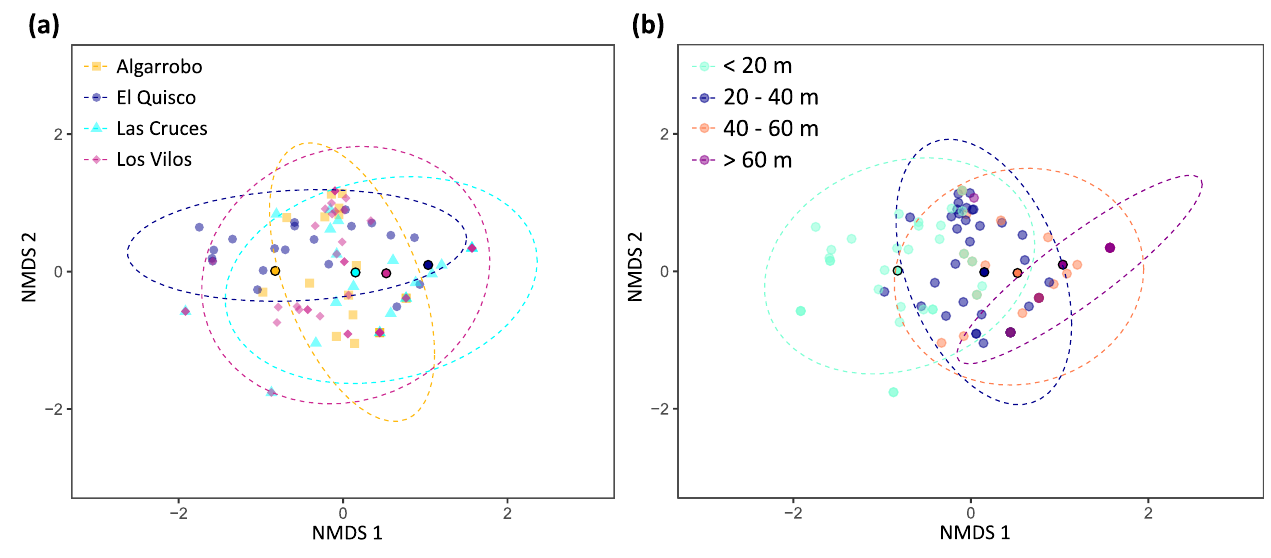
Figure 5. Non-metric multidimensional scaling (nMDS) plot using a Bray–Curtis dissimilarity matrix (dimensions = 2, stress = 0.10, Shepard plot non-metric R 2 = 0.99). ( a ) Sites. ( b ) Depth strata. Ellipses include 95% of the data for each group. Dots with black borders and a more intense colour indicate the centroids for each